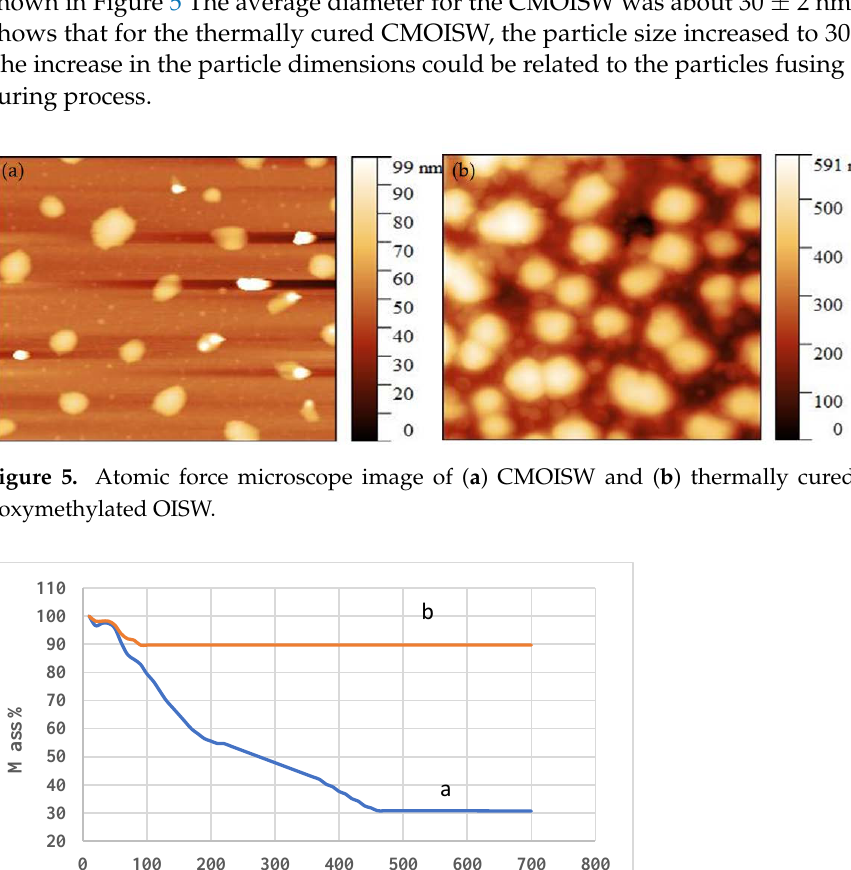
Figure 6. Thermal gravimetric analysis of ( a ) carboxymethylated OISW ( b ) thermal cured carboxymethylated OISW.